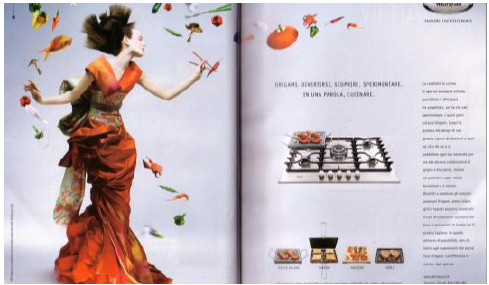
Figure A11. Own selected picture, Exotic woman.